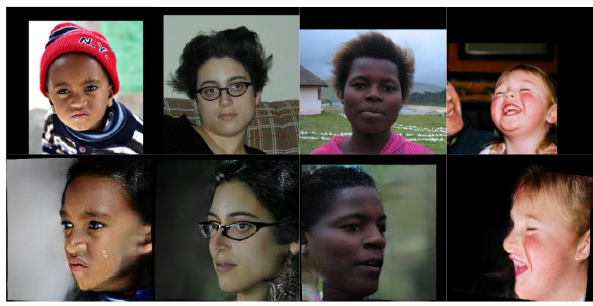
Figure 27. Synthetic rotations of images in